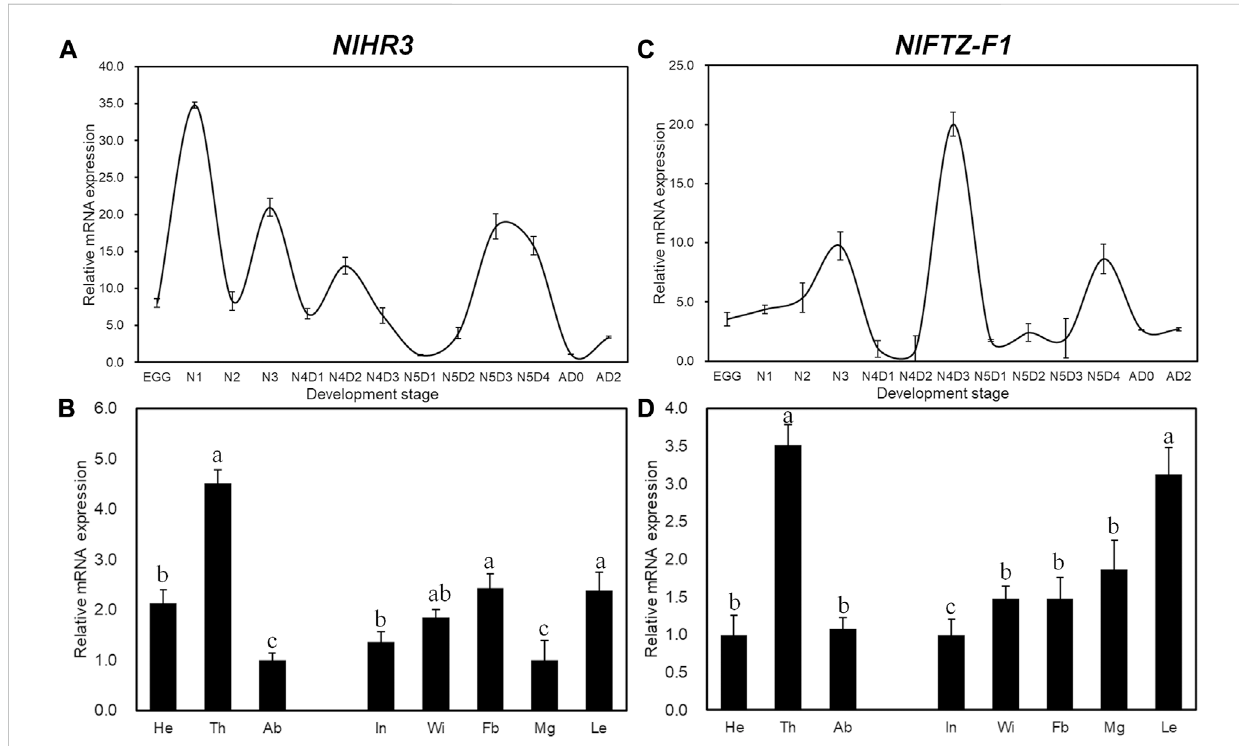
FIGURE 1 Temporal and spatial expressionpro fi les of NlHR3 and NlFTZ-F1. (A, C) Relative expression levels of NlHR3 and NlFTZ-F1 at different developmental stages. N1 (the fi rst instar nymph) to N5D4 (day 4 of the fi fth instar nymph), New-A (newly emerged female adults), and AD2 (2-day-old female adults). (B,D) : NlHR3 and NlFTZ-F1 relativeexpressionlevelsofthehead(He),thorax(Th),abdomen(Ab),integument(In),wingbud(Wi),midgut(Mg),leg(Le),and fat body (Fb) of nymphs (fourth – fi fth instar). The standard error (SE) was determined from three independent biological replicates, each with three technical replications. Different letters indicate a signi fi cant difference at a p -value < 0.05 (Tukey ’ s test).